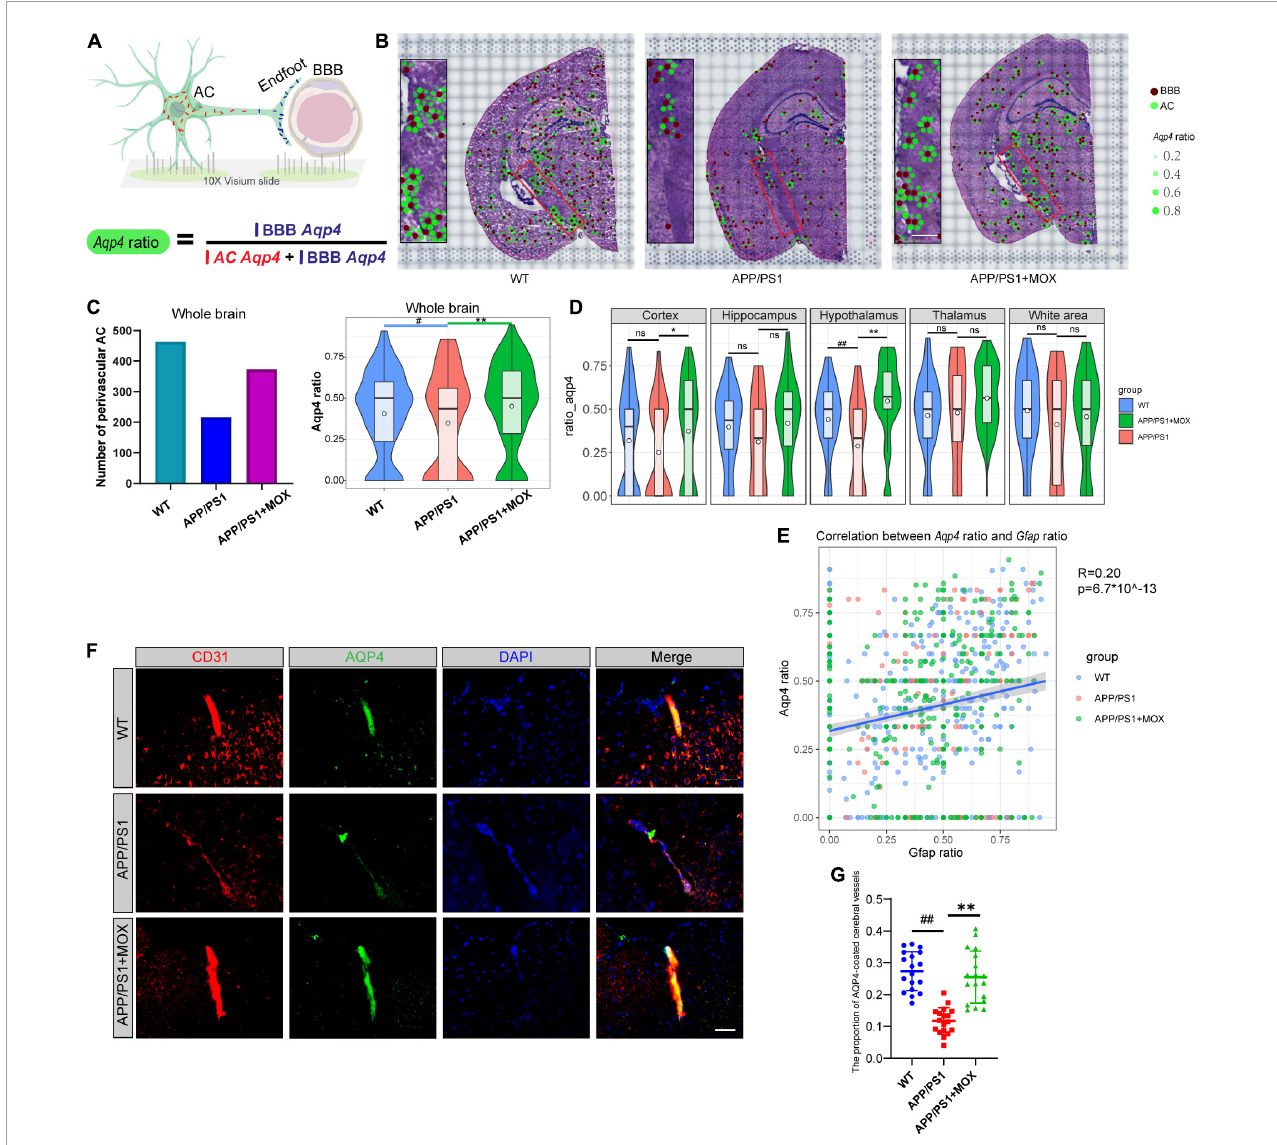
FIGURE3 The reduction of the Aqp4 ratio in APP/PS1 mice. (A) Schematic diagram of the calculation method of Aqp4 ratio, which represents the Aqp4 mRNA transport capacity of astrocyte to endfoot. (B) Brain maps of the Aqp4 ratio. The brown points represent BBBs, and the green points represent ACs. The size and alpha of the green points represent the magnitude of the Aqp4 ratio. Scale bar, 0.3 mm. (C) Barplot of the number of perivascular AC and violin plots of Aqp4 ratio in brains. (D) Violin plots of Aqp4 ratio of different brain regions. (E) A scatter diagram showing the correlation between the Aqp4 ratio and Gfap ratio in AC. R, Pearson’s correlation coefficient; p, Pearson’s correlation test p -value. (F) IF analysis using CD31 and AQP4 antibodies of the brain. Blue, DAPI; red, CD31; green, AQP4. Scale bar, 40 µ m. (G) Dot plot of the proportion of AQP4-coated cerebral vessels ( N = 18). One-way analysis of variance with post-test # P < 0.05, ## P < 0.01, APP/PS1 vs. WT; * P < 0.05, ** P < 0.01, APP/PS1 + MOX vs.